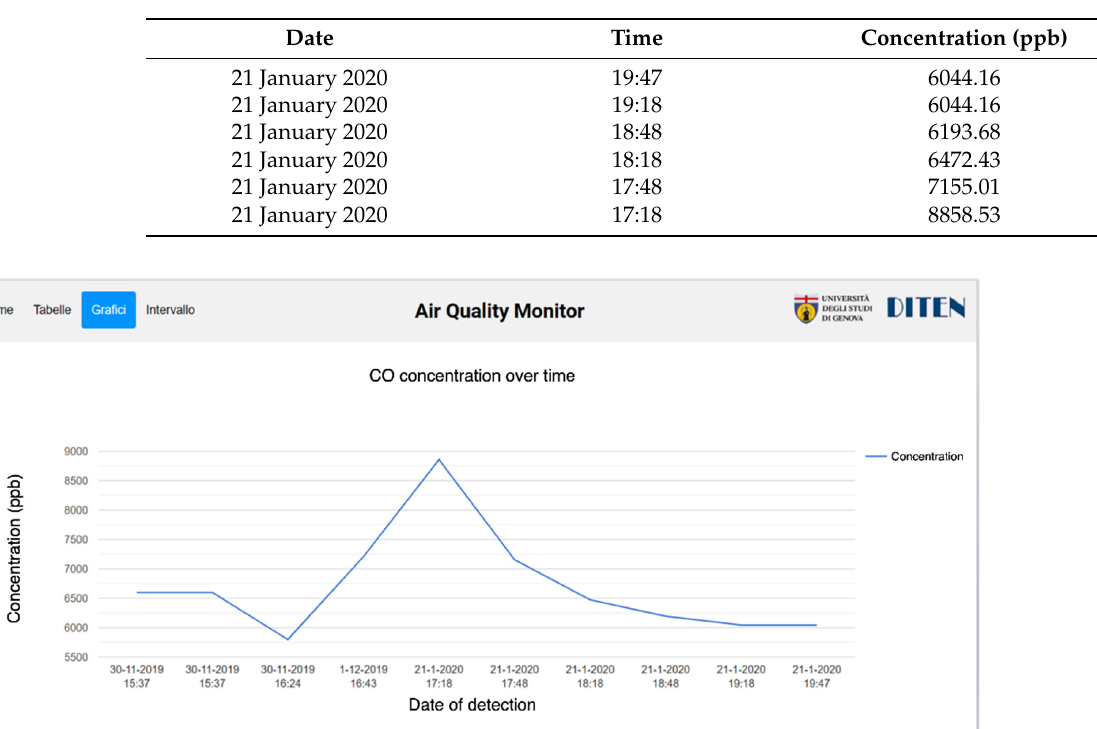
Table 6. Measurements of the air quality system related to CO concentration in tabular format.